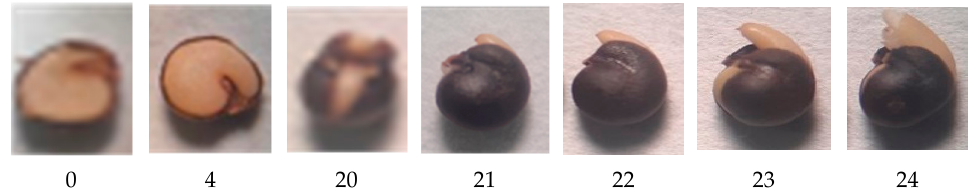
Figure 2. From left to right, photographs correspond to the number of days elapsed since the start of the germination test (Day 0; dry mature seed) through to the opening of the testa (Day 20) and elongation of the hypocotyl and radicle inside the endosperm (from Day 20 to 23), until the rupture of the micropylar endosperm (Day 24). On Days 0 and 4, half of the testa was removed to observe the state of the endosperm.